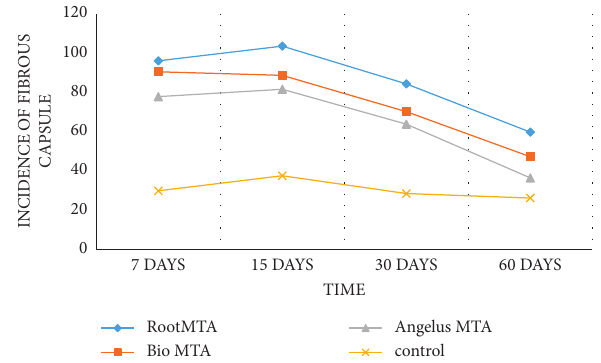
Figure 3: Fibrous capsule sizes in different groups in 7, 15, 30, and 60 days. Table 1: Mean scores and standard deviation of the fibrous capsule after 7, 15, 30, and 60 days and p value for comparison of test groups and each group in different time